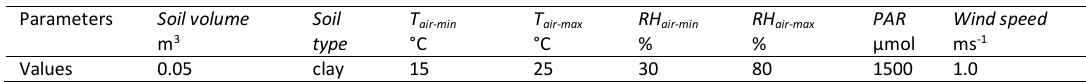
Table 2. Main pedoclimatic conditions use for the control